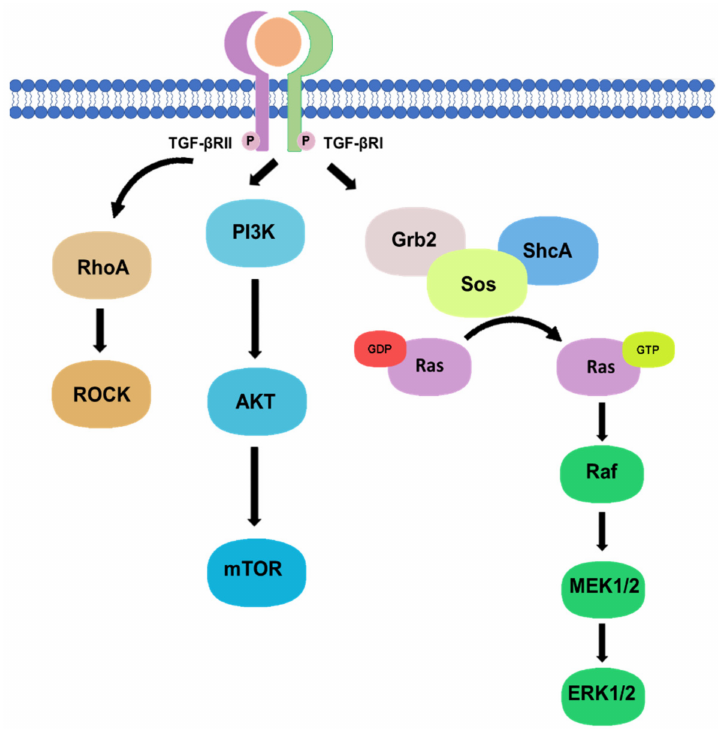
Figure 2. Non-canonical pathway of TGF- β